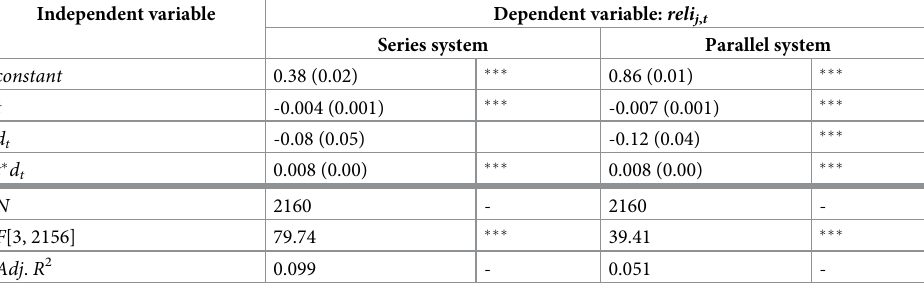
F [3, 2156] 79.74 ��� 39.41 ��� Adj . R 2 0.099 - 0.051 - Values in parentheses are standard deviations. � , �� , and ��� denote statistical significance at the 10%, 5%, and 1% levels,